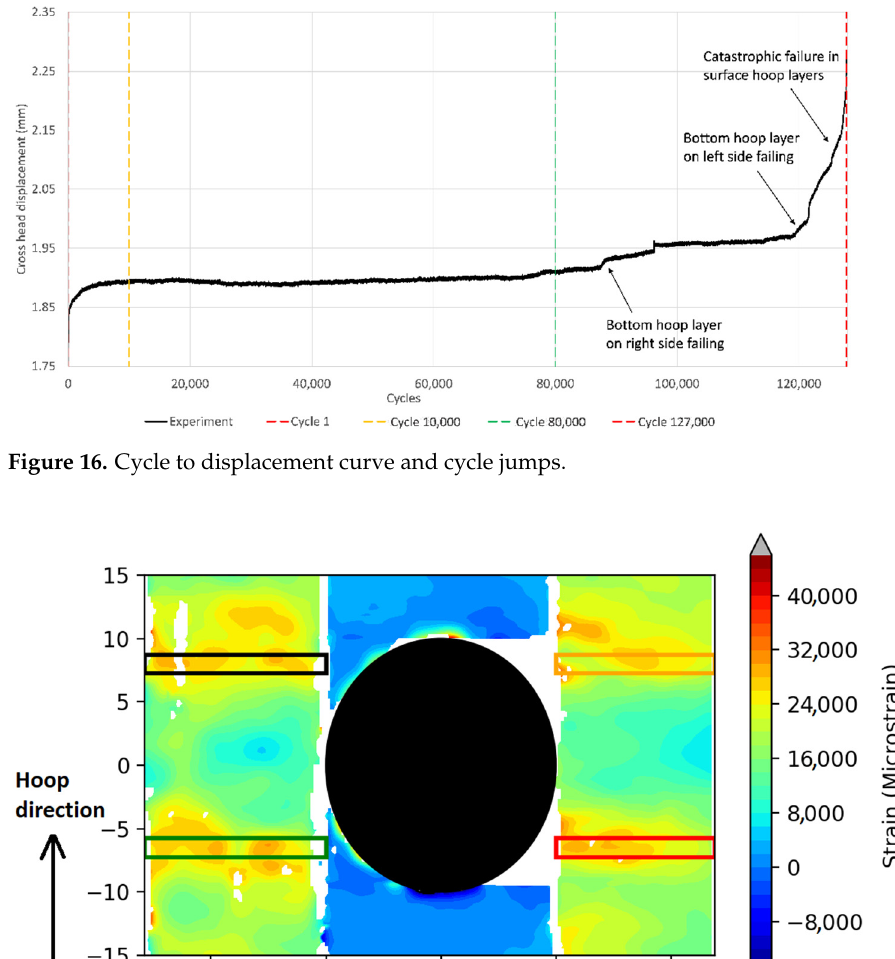
Figure 18. Hoop strain curves from the regions in Figure 17 for different cycles.